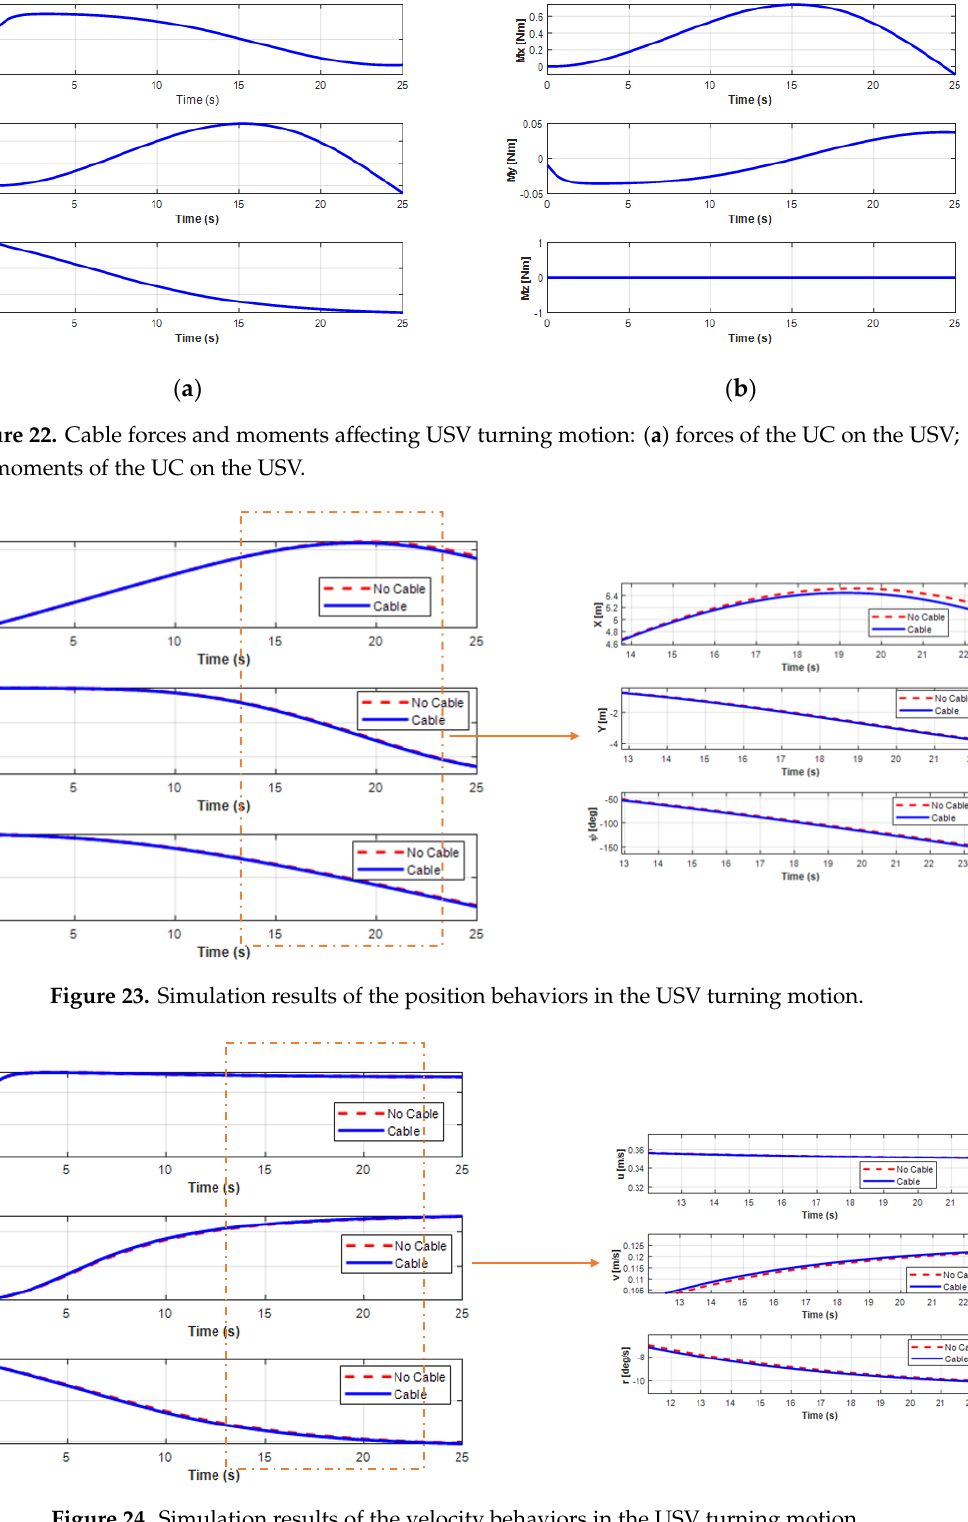
Figure 24. Simulation results of the velocity behaviors in the USV turning motion.